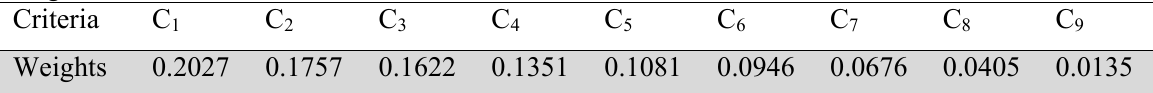
Weights of the criteria